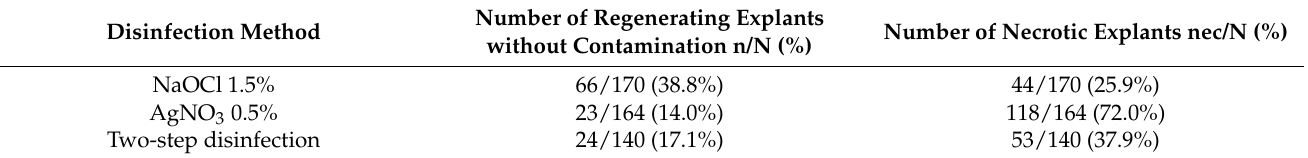
Table 3. Disinfection efficiency and regeneration rate of S. myrtilloides explants depending on the disinfection method.